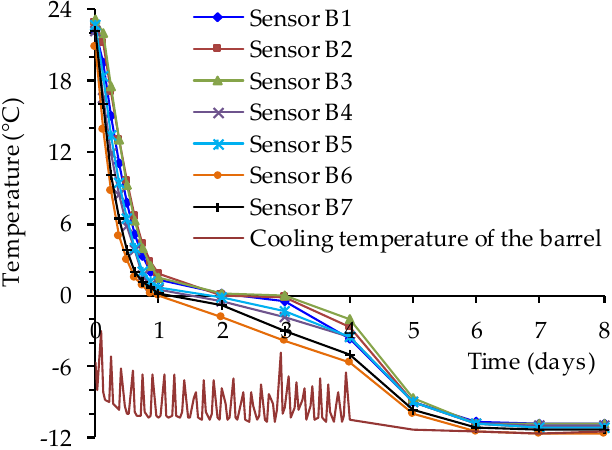
Figure 4. Sensor recordings of temperature changes over time in the backfill containing 5% binder in the barrel cooled at −11 °C.